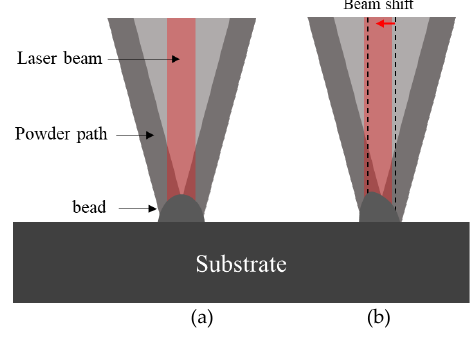
Figure 4. Schematic diagram of beam alignment: ( a ) center beam, ( b ) 0.5 mm shifted beam.